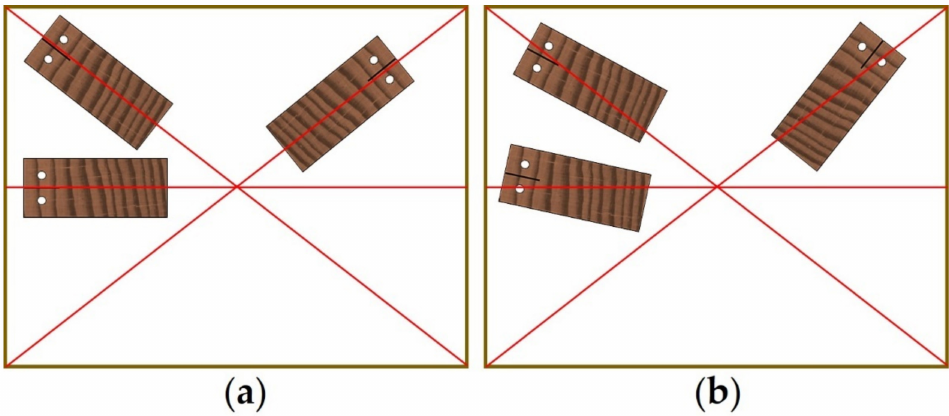
Figure 3. ( a ) Samples carved from the slice with a grain angle of 0 ◦ , i.e., fracture follows the direction of the growth rings; ( b ) samples carved with a grain angle different from 0 ◦ with respect to the growth ring